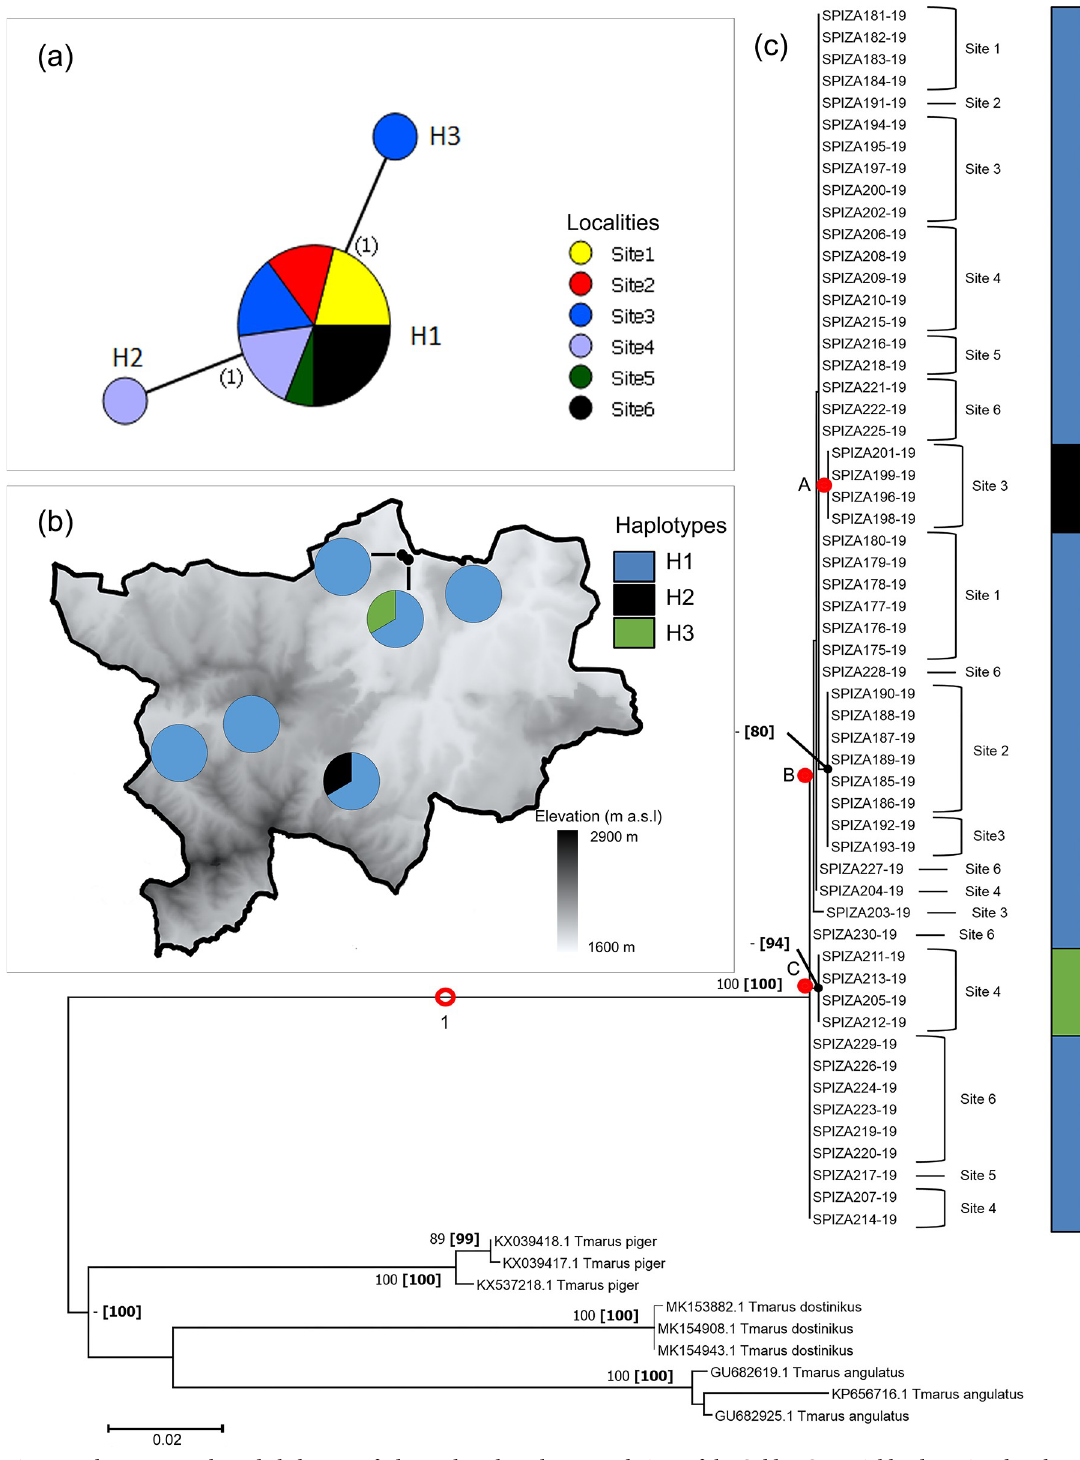
Fig 4. Haplotype networks and phylogram of Pherecydes tuberculatus populations of the Golden Gate Highlands National Park, based on a portion of mt DNA COI gene. (a) Minimum Spanning Network (MSN) connecting sampled sequences through putative mutational steps according to geographical locality of populations. Circles represent defined haplotypes, while circle diameters are proportional to frequency. Numbers in parentheses correspond to mutational steps. (b) Distribution of defined haplotypes within sampled localities. (c) Phylogenetic tree based on Maximum Likelihood (ML) showing relationship of P . tuberculatus with three species